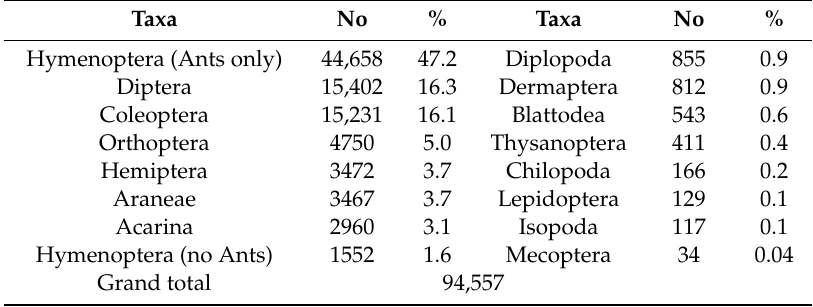
Table 2. Total number and relative abundance of invertebrate taxa, collected in pitfall traps over eight sampling periods in two calendar years (n = 3840 pitfall traps).